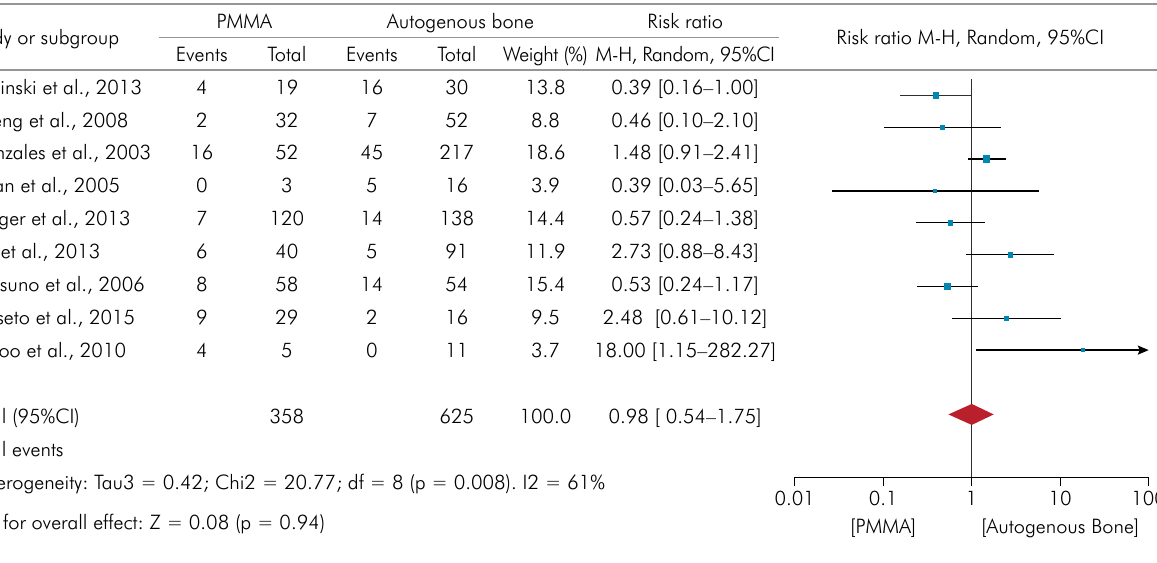
Figure 2. Forest plot: comparison between PMMA and autologous bone grafts with respect to complications.